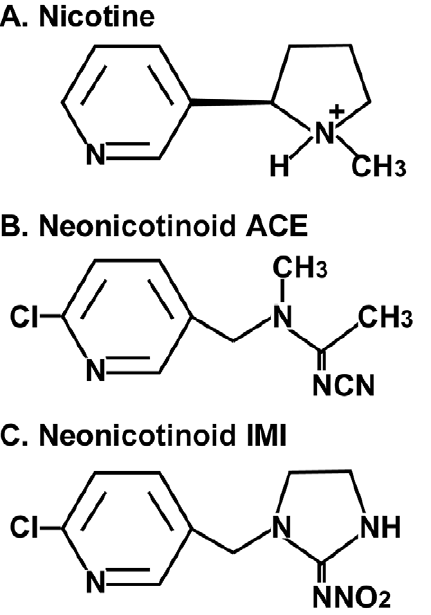
Figure 2. Molecular structures of nicotine and the neonicoti- noids ACE and IMI. ( A ) nicotine, ( B ) acetamiprid (ACE), ( C ) imidacloprid (IMI).